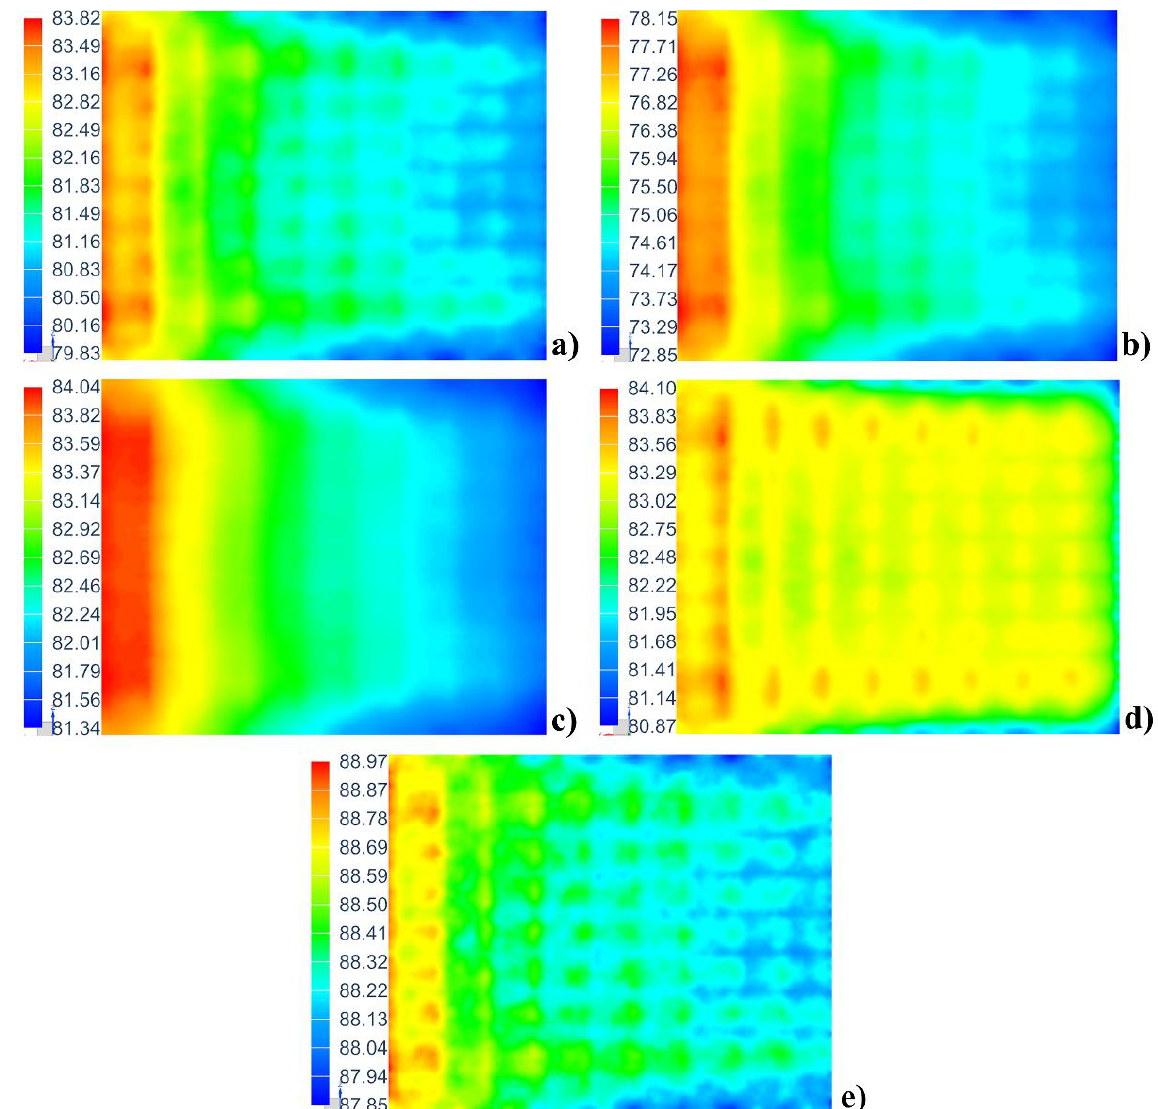
Figure 17. Temperature contour plot of the mold panel (unit: °C): ( a ) steel-Q345 and air, ( b ) aluminum-6061 and air, ( c ) copper-C10100 and air, ( d ) steel-Q345 and argon, and ( e ) steel-Q345 and helium.